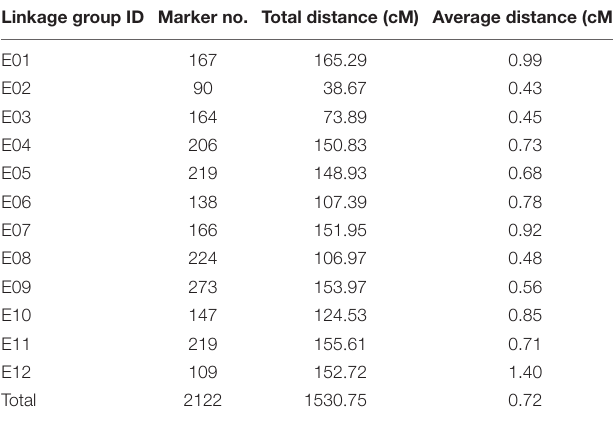
TABLE 2 | Information on the SNP-based genetic map of eggplant.